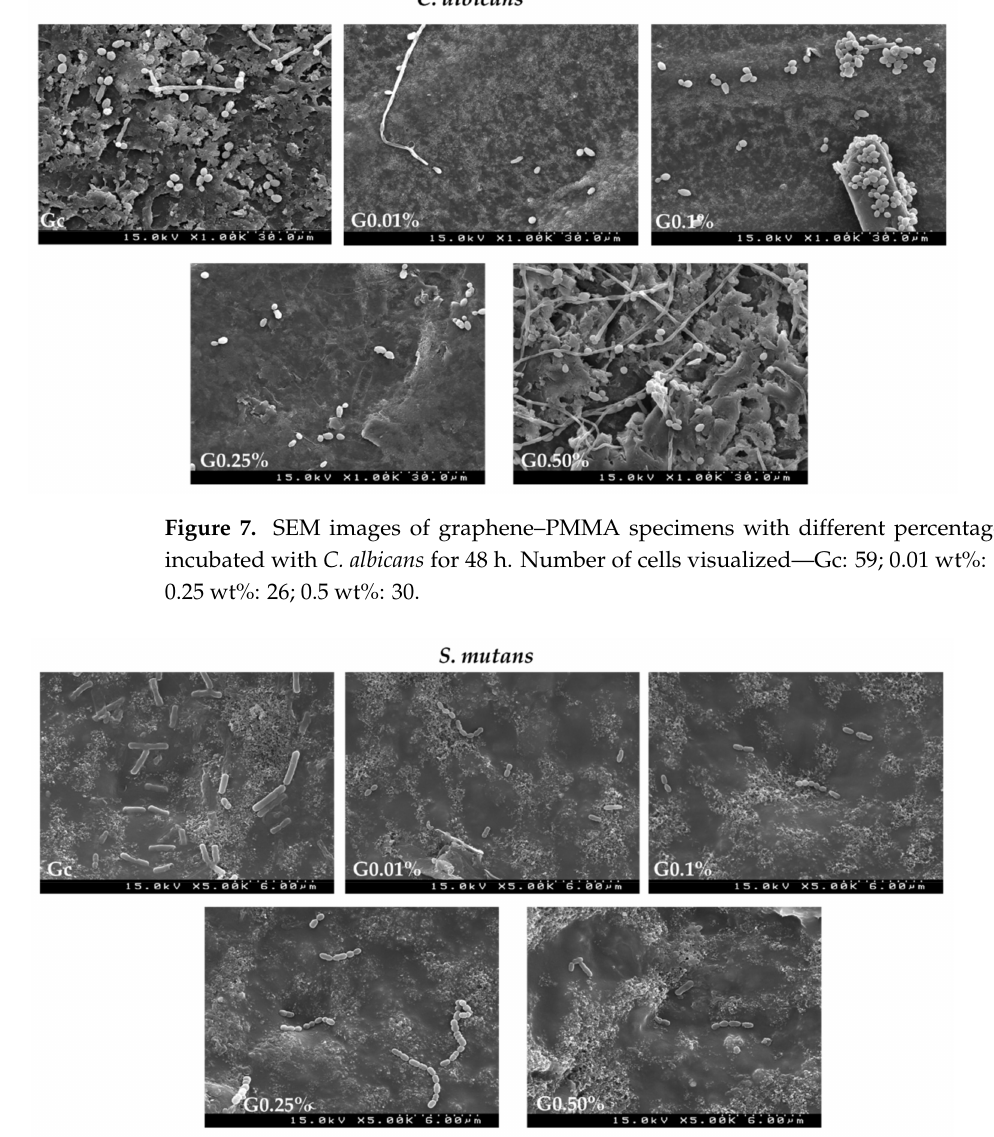
Figure 8. SEM images of graphene–PMMA specimens with different percentages of graphene incubated with S. mutans for 48 h. Number of cells visualized—Gc: 34; 0.01 wt%: 17; 0.1 wt%: 14; 0.25 wt%: 18; 0.5 wt%: